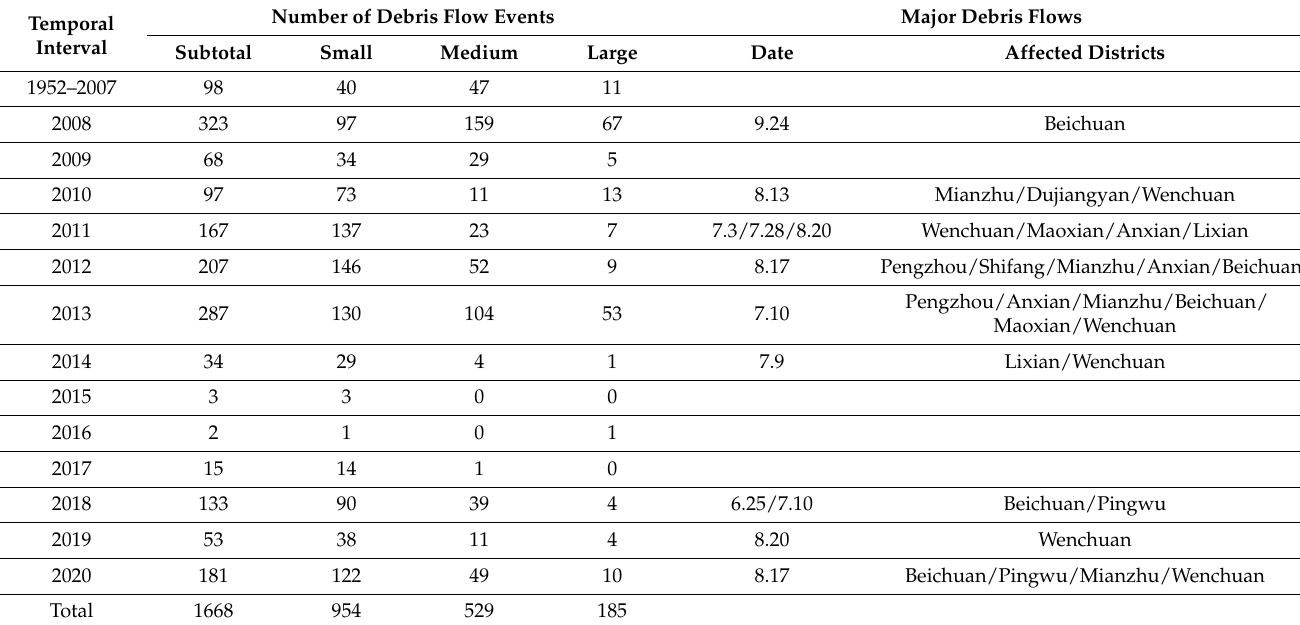
Table 4. Statistics of the debris flow events over